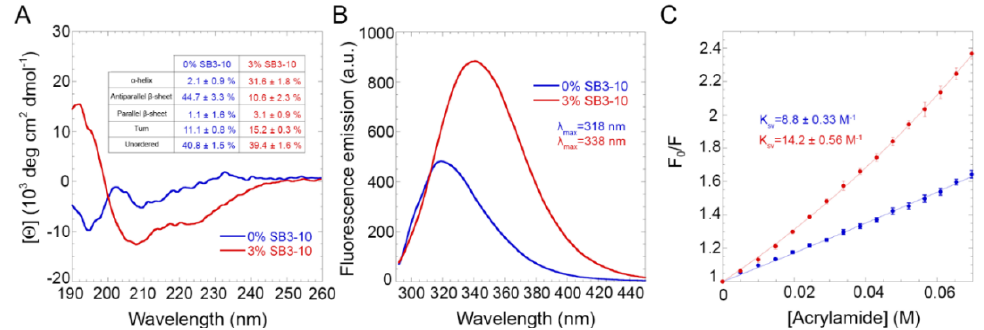
Figure 1. Structural characterization of TDP-43 NTD. Far-UV CD spectra ( A ), Intrinsic fluorescence spectra ( B ) and Stern-Volmer assays ( C ) of TDP-43 NTD in 0.0% (blue) and 3.0% (red) SB3-10. All SB3-10 percentages are w/v . The writings inside the panels indicate the values obtained for the ana- lysed parameters.